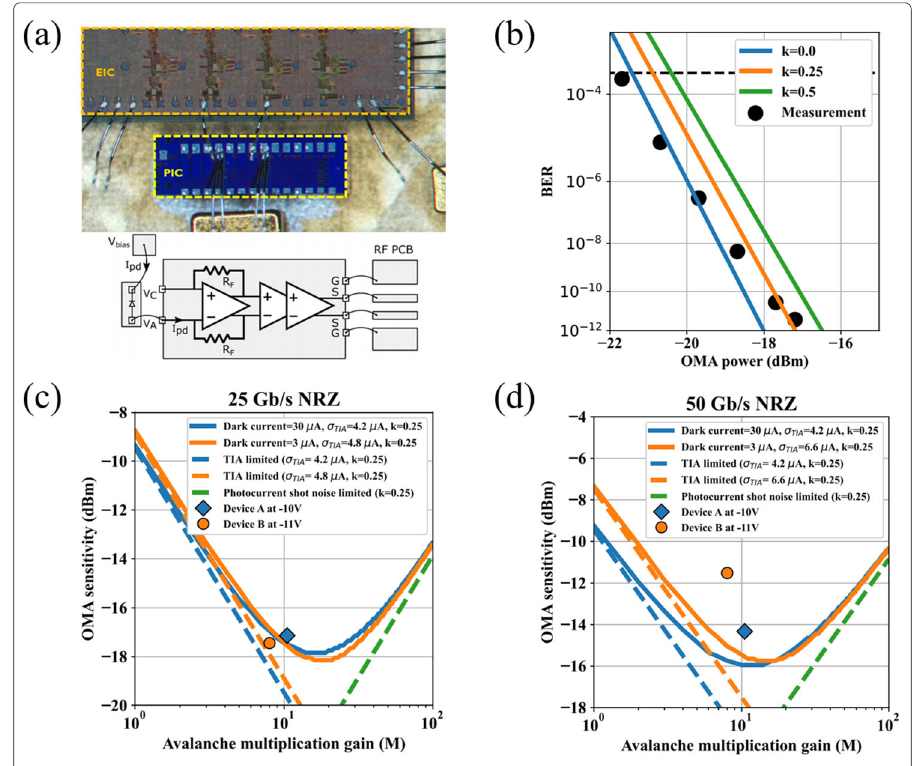
Fig. 14 a Prototype of the APD BiCMOS receiver; b Measured BER data and extracted k value; Receiver sensitivity analysis at c 25 Gb/s and d 50 Gb/s